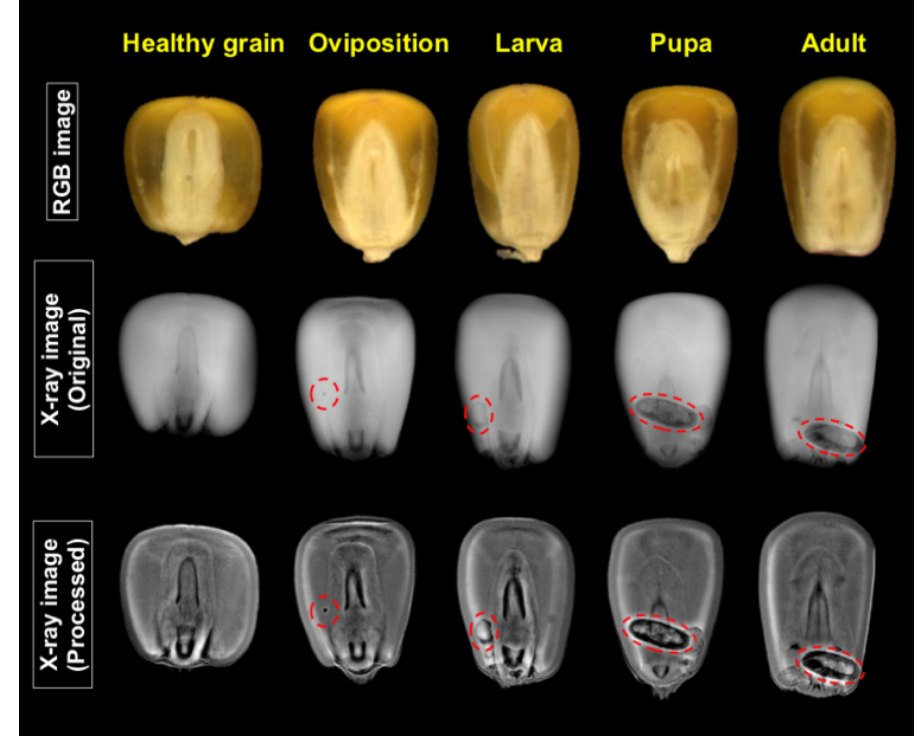
Figure 3. RGB images of non-infested maize grains (healthy grain) and grains infested with Sitophilus zeamais during oviposition, larva, pupa and adult stages and corresponding traditional X-ray images and after processing using peripheral equalization and calcification emphasis algorithms. Red circles/ellipses indicate infested regions inside the grain.